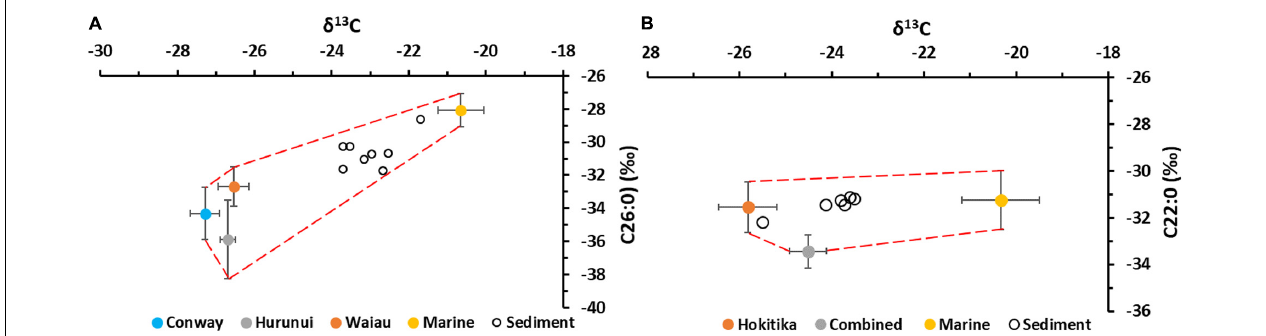
FIGURE 3 | Examples of polygons built using the river mouth sediment and marine sediment CSSI values enclosing all of the (A) Kaik¯oura Canyon and (B) Hokitika Canyon surface sediment CSSI values. All sediment samples from the canyons (open circles) lie inside their respective polygons (red dashed lines) drawn through the error bar values of the potential sediment sources. The legend labeled “Combined” (Hokitika Canyon) stands for the Whataroa, Mikonui, Waitaha and Wanganui rivers. Error bars stand for one standard deviation.